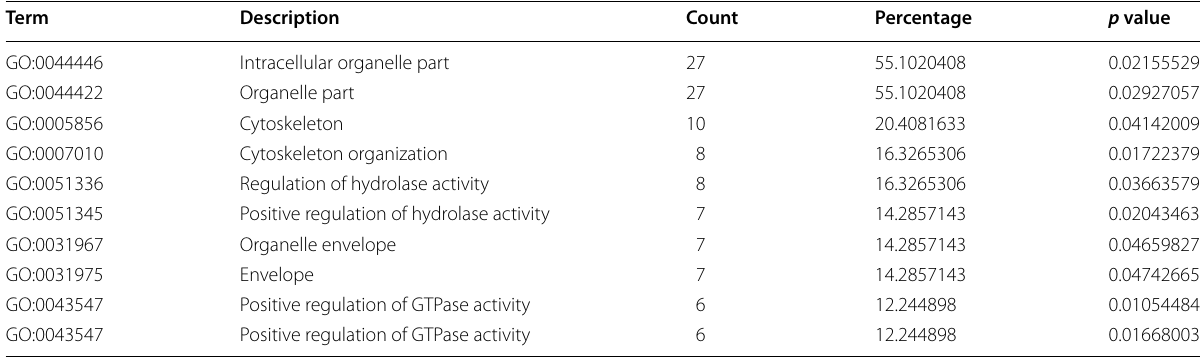
Table 2 Top 10 significantly enrichment analysis of hyper-methylated DMGs in periodontitis tissues